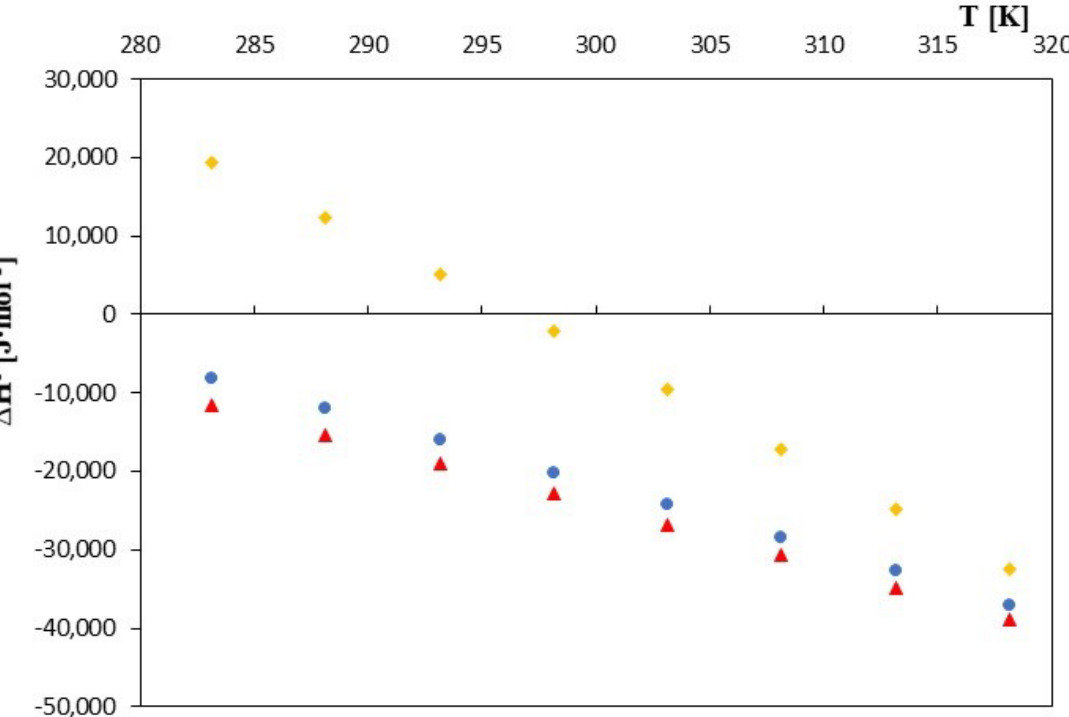
Figure 6. The plots of dependence ∆ H 0 [J · mol − 1 ] in the function T [K] for (cid:78) — α -cyclodextrin, • — β - cyclodextrin and (cid:7) —2-HP- β -cyclodextrin with all studied salt of dodecanoic